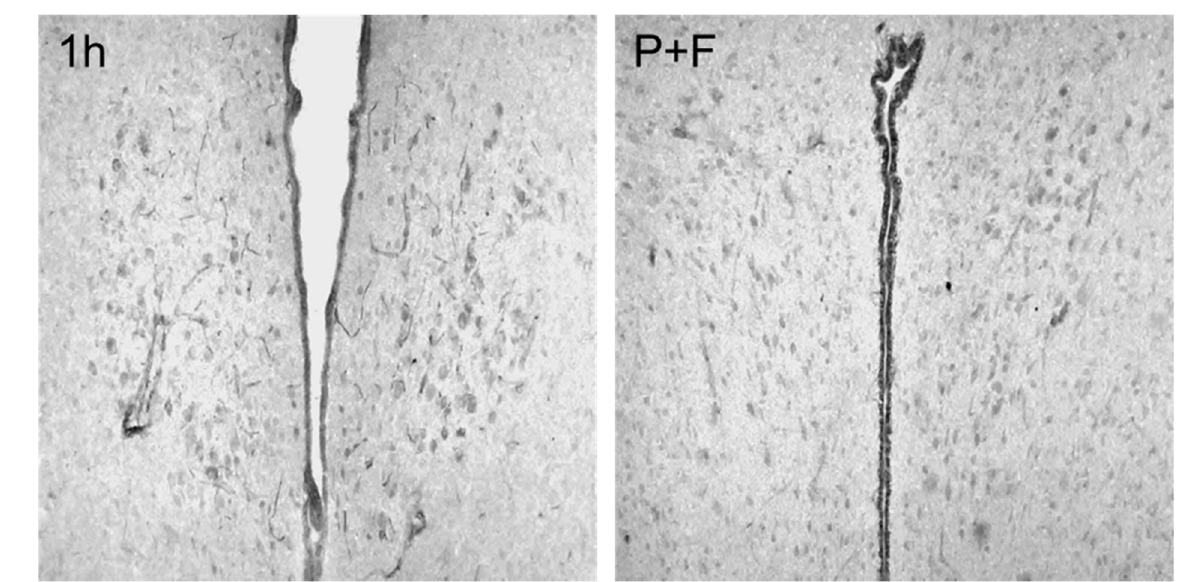
Figure A11. Androgen-receptor immunoreactivity in the paraventricular nuclei of Syrian hamsters. Comparison between 1 h manual sleep deprivation (1 h, group 3a) and sexual stimulation with pheromone and females (P+F, group 1). Magnification: 80 × .